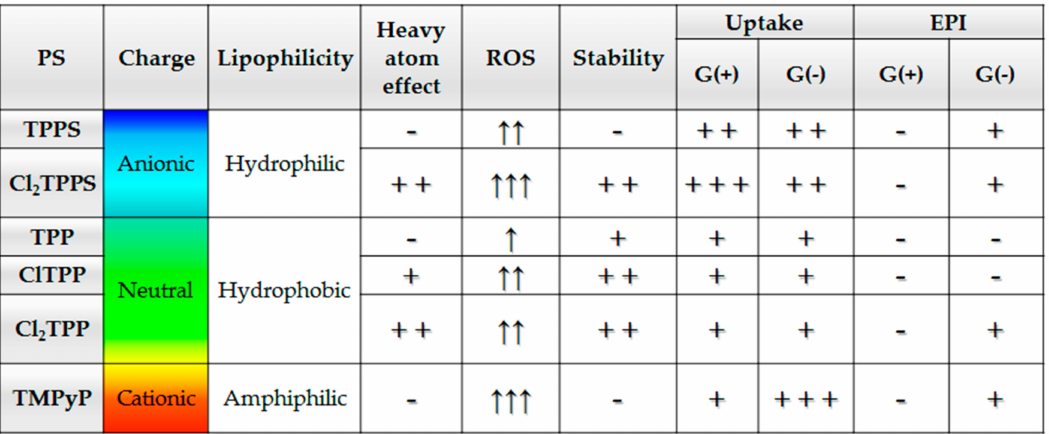
Figure 21. A summary of the factors influencing the e ffi cacy of photodynamic photoinactivation. The structural modification of porphyrins and their influence on photophysical and biological activity in the performed experiments. Abbrev. In order: - /+/++/+++ or ↑ / ↑↑ / ↑↑↑ = no e ff ect or the worst / moderate / most